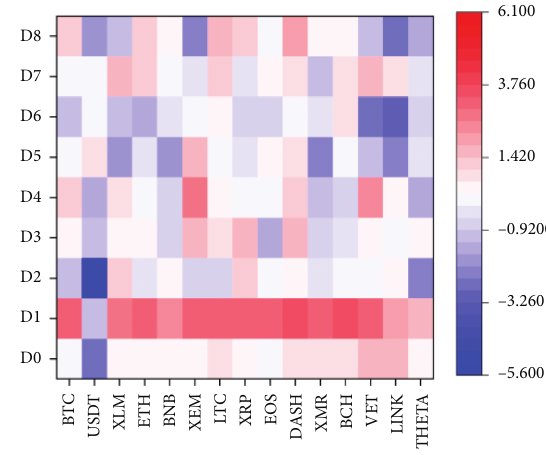
Figure 19: DASH to the